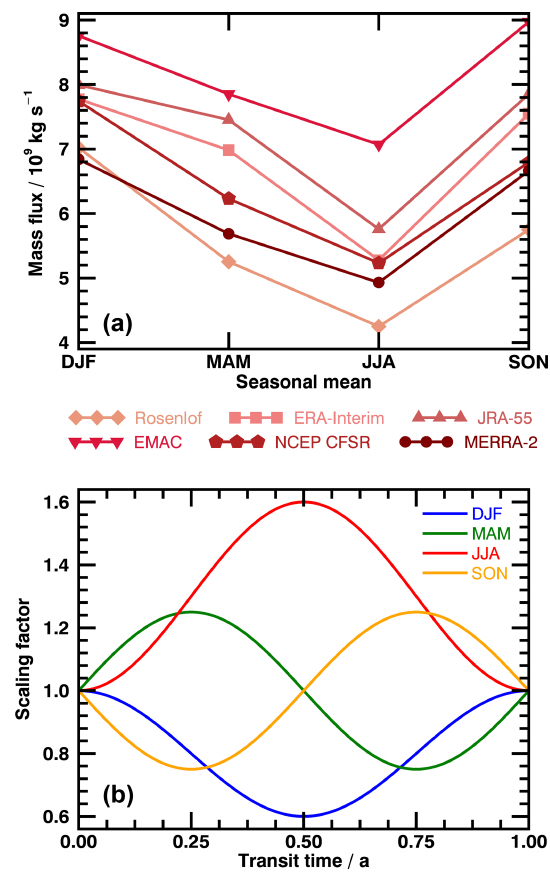
Figure 1. (a) shows the tropical upward mass flux at 70hPa. Data are from four reanalyses as well as the evaluated EMAC simulation and Rosenlof (1995). (b) illustrates derived scaling factors of age spectra in 1 year as a function of transit time. The four seasons are color coded. Increasing transit time means backward in time. The starting point of each curve is equivalent to the season it depicts.